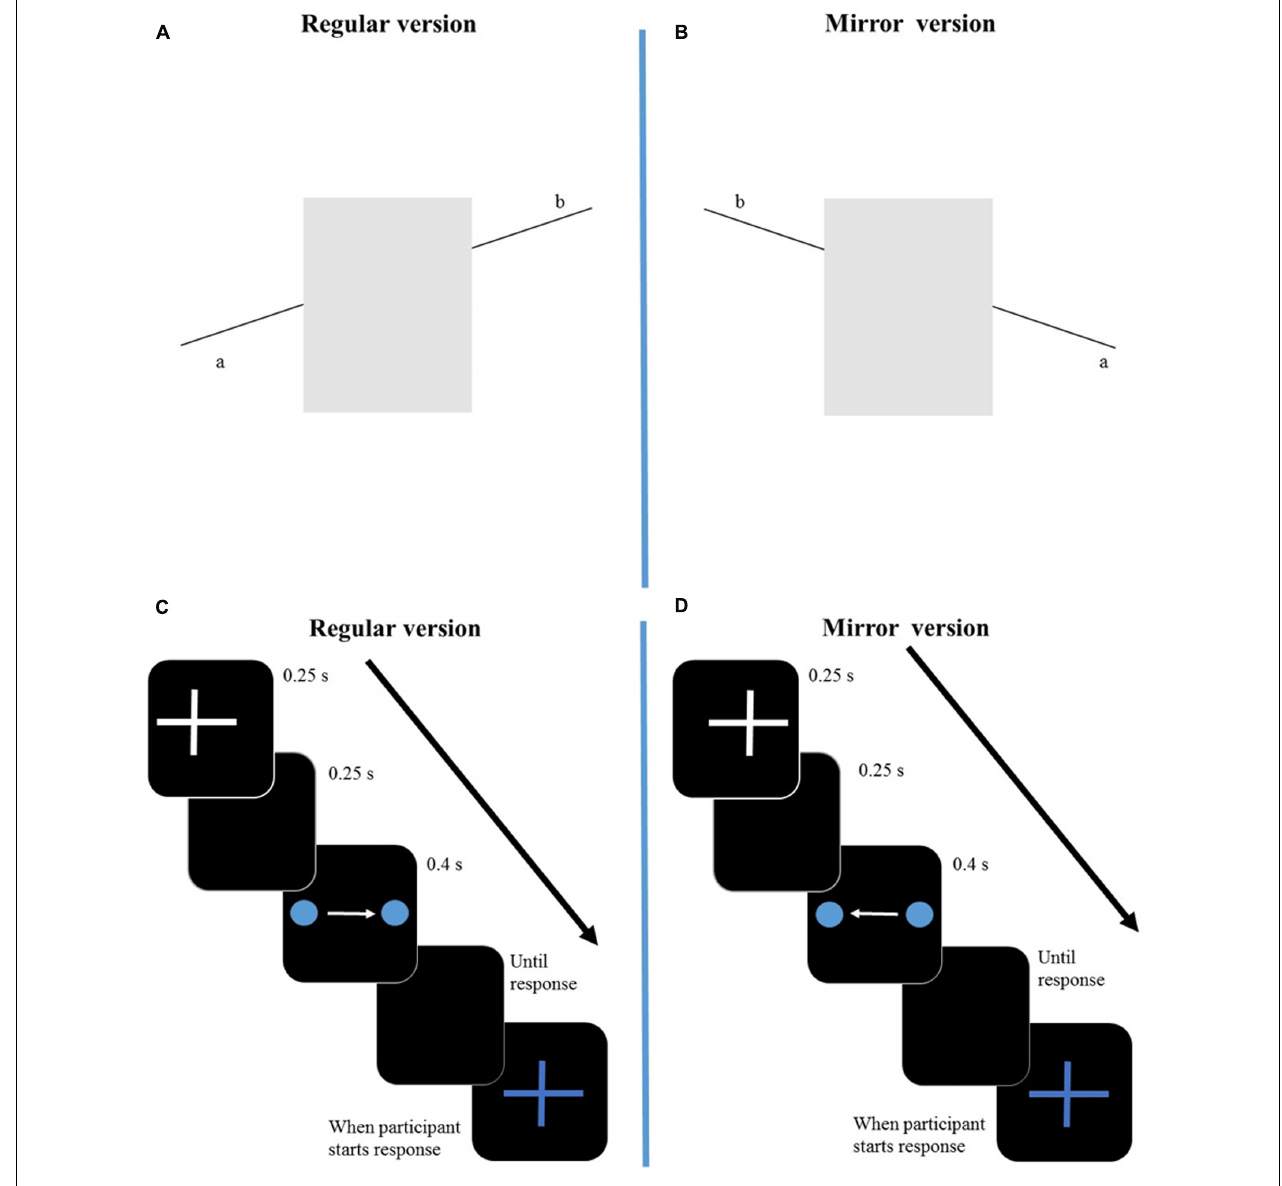
FIGURE 1 | Representation of the regular version (left side) and mirror version (right side) of the two illusions. In the regular version of the Poggendorff illusion (A) , participants need to align the line on the right (b) with the line on the left (a). In the mirror version of the Poggendorff illusion (B) participants align the line on the left (b) with the line on the right (a). In the VP illusion regular version (C) , the dot moves from the left side to the right side, where it disappears. In the mirror version (D) the dot moves form the right side of the screen to the left one. Stimuli are not drawn to scale. The arrow represents time from start of trial until participant’s response. S,